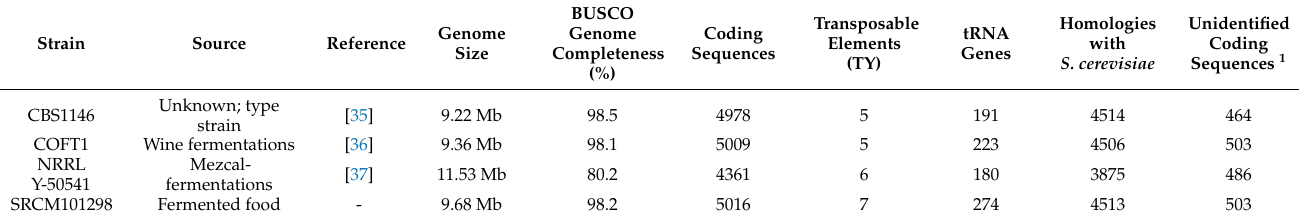
Table 1. Torulaspora delbrueckii genomes used in this study and the corresponding number of protein-coding sequence (CDS) transposable elements and transfer RNA (tRNA) genes predicted by Yeast Genome Annotation Pipeline (YGAP).